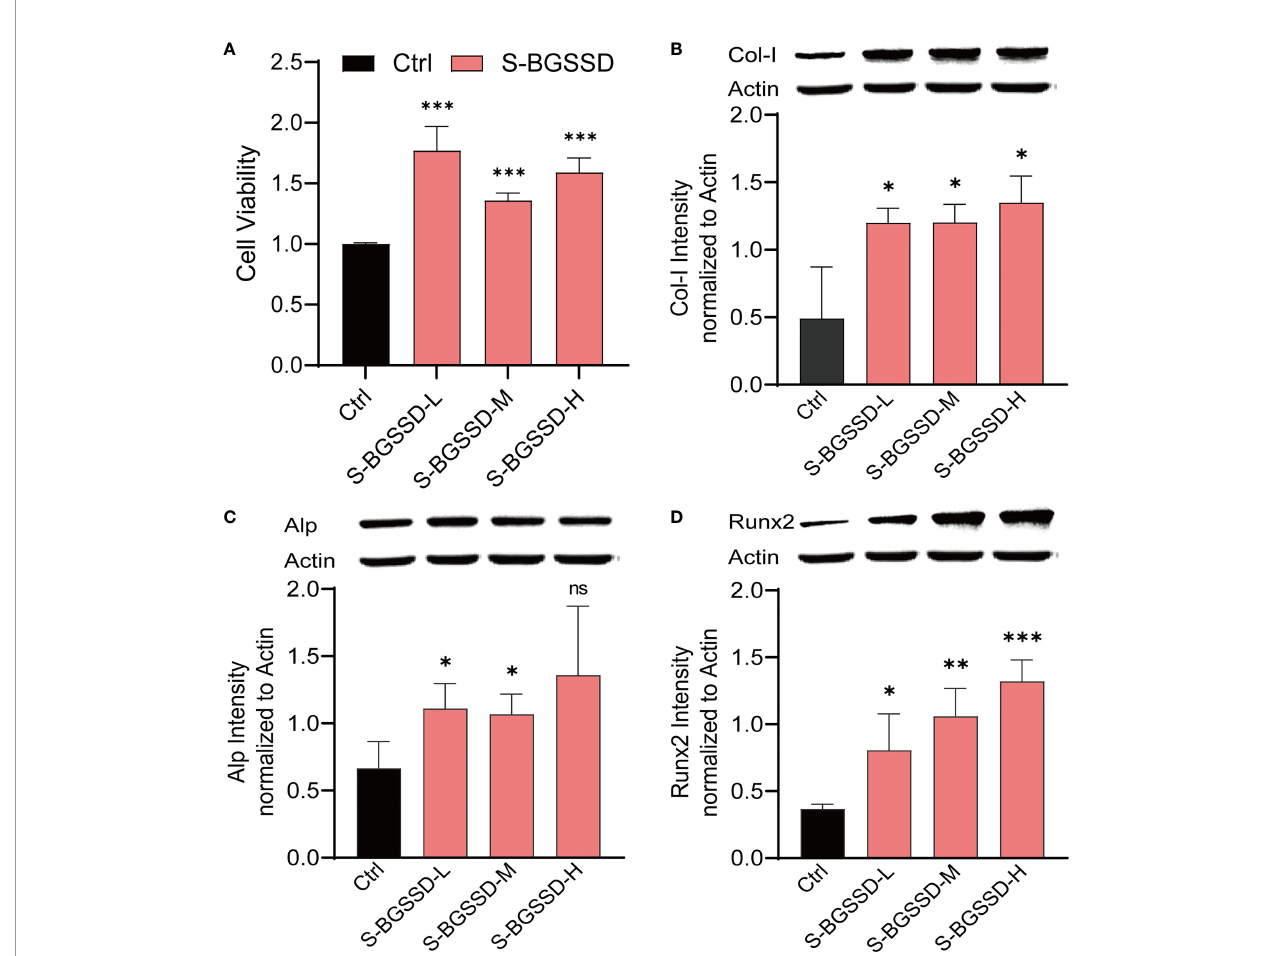
FIGURE 3 | The results of drug-containing serum of BGSSD intervening in the proliferation and differentiation of serum-deprivation-induced MC3T3-E1 cells. (A) MTS assay analysis of the viability of MC3T3-E1 cells dealt with the drug-containing serum of low, medium, and high doses of BGSSD (to eliminate the in fl uence of rat serum on cells, all the Ctrl group was treated with the drug-free serum of rats). (B) Western blot and quanti fi cation (underneath the blots) of Col-I in MC3T3-E1. (C) Western blot and quanti fi cation (underneath the blots) of Alp in MC3T3-E1. (D) Western blot and quanti fi cational analysis (underneath the blots) of Runx2 in MC3T3-E1. Asterisks denote the comparison to serum-starved cells treated with rats ’ blank serum (Ctrl). All intervening times of drug-containing serum of BGSSD were 48 h; b -actin served as the internal control in all Western blots. Data are presented as the mean± s.e.m., *p < 0.05, **p < 0.01, *** p < 0.001, n = 3 per group. NS, not statistically signi fi